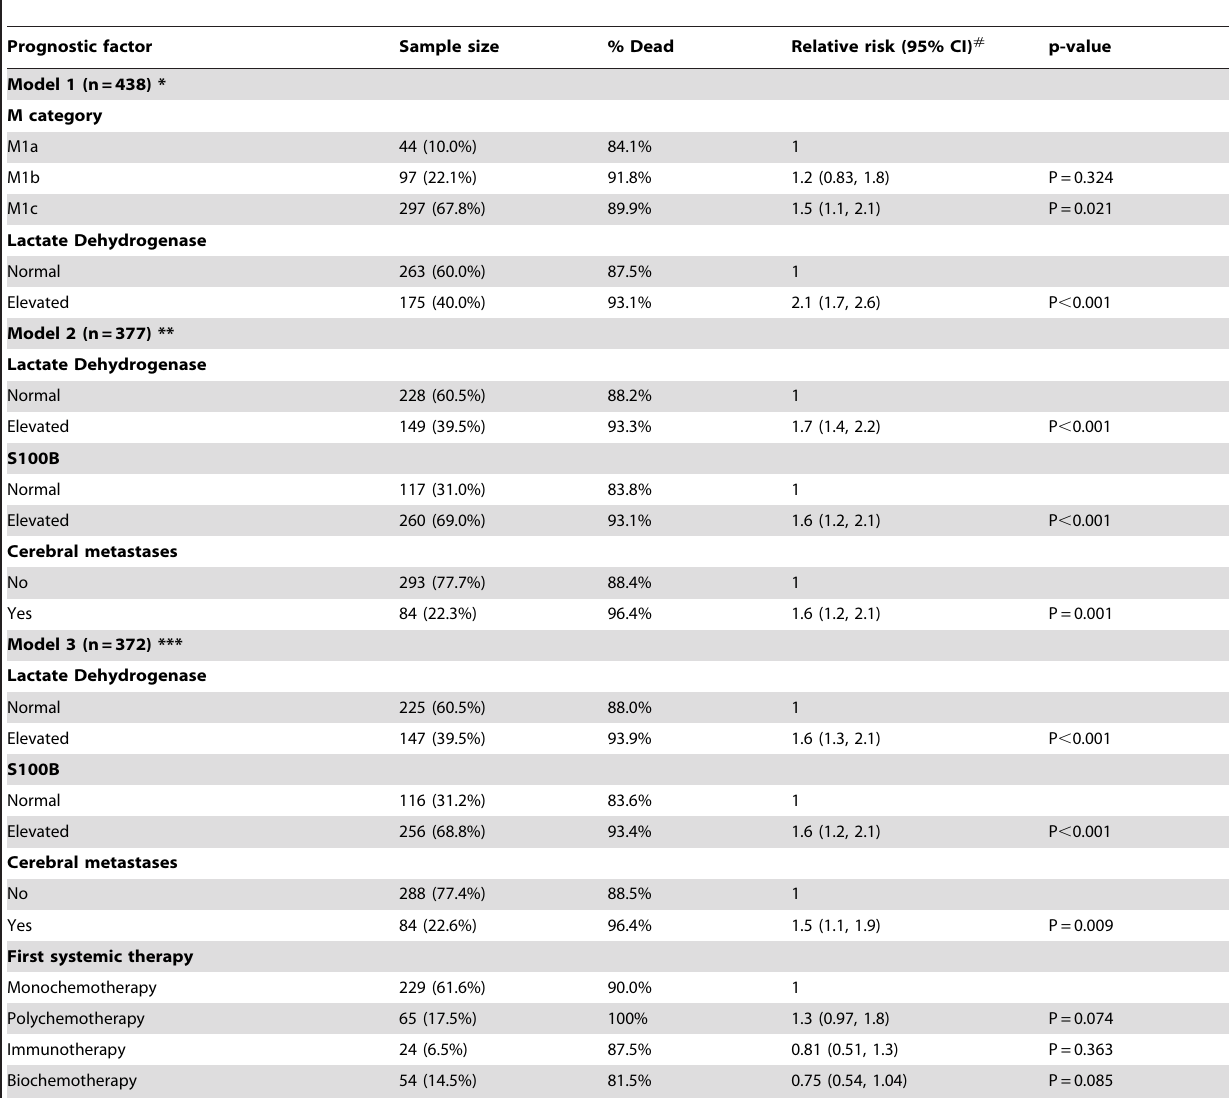
Table 2. Multivariate analysis for disease-specific